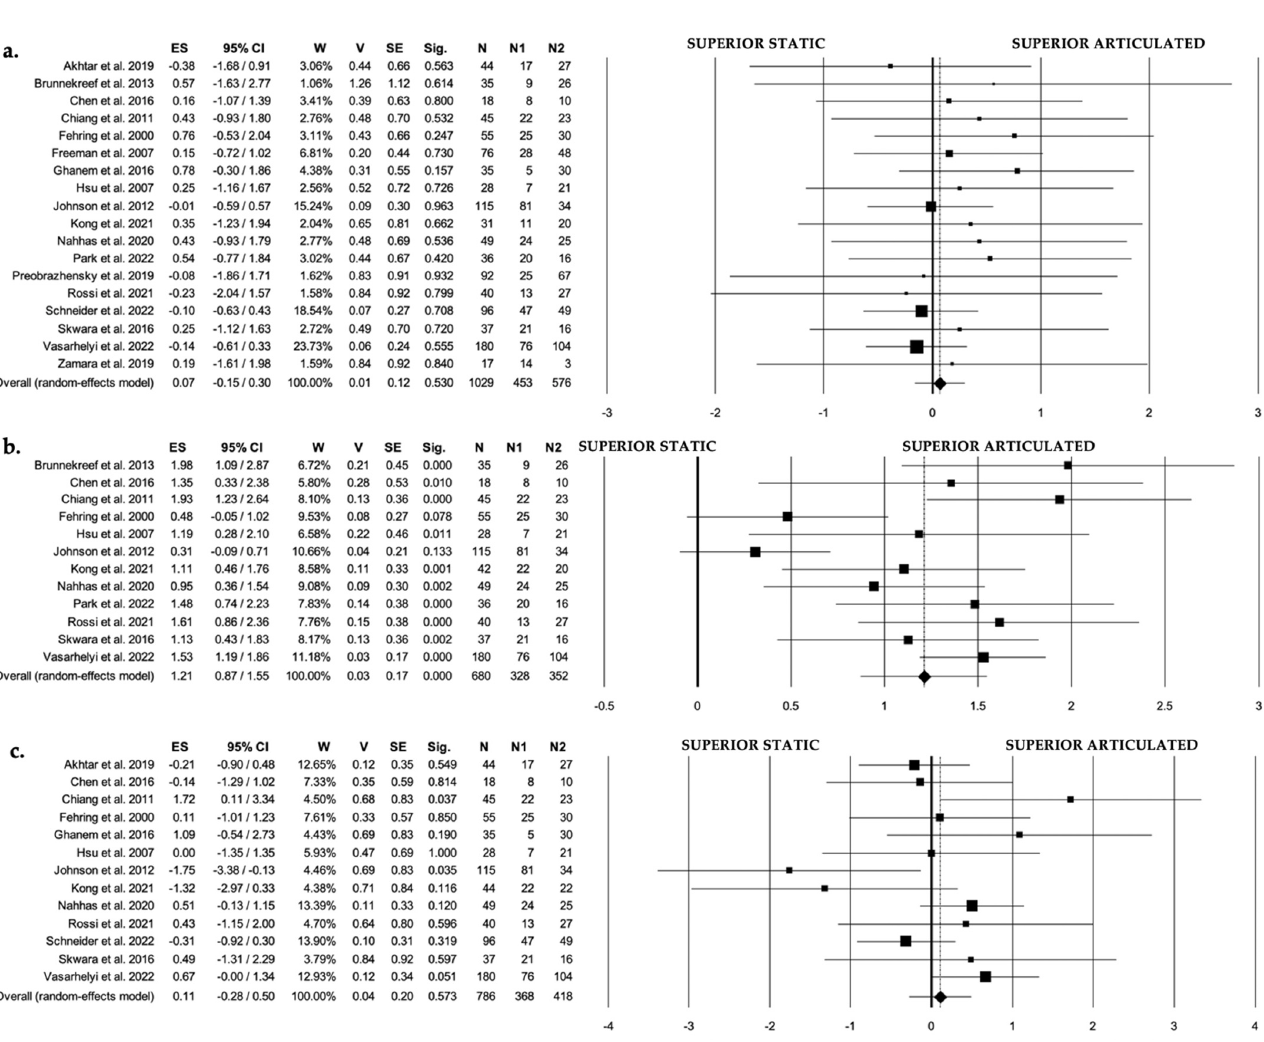
Figure 3. Forest plot of overall meta-analysis evaluating comparative studies (static spacers vs. articulated spacers) with data about PJI recurrences [21,23–25,29–31,34,38,39,43,44,46–48,50,52,54] ( a ), active knee flexion at last follow-up ( b ), and non-infection-related peri-operative local complications ( c ). Abbreviations: ES, effect size; 95% CI, 95% confidence interval; W, weight; V, variance; SE, standard error; N, sample size; N1, static spacer series sample size; N2, articulated spacer series sample size.